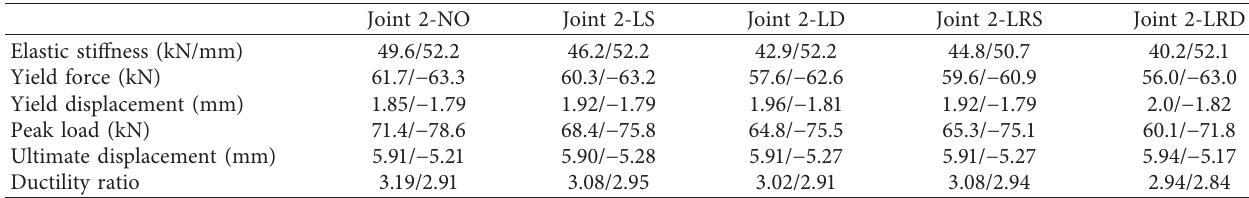
Table 4: Summary of the mechanical parameters of Joint 2.